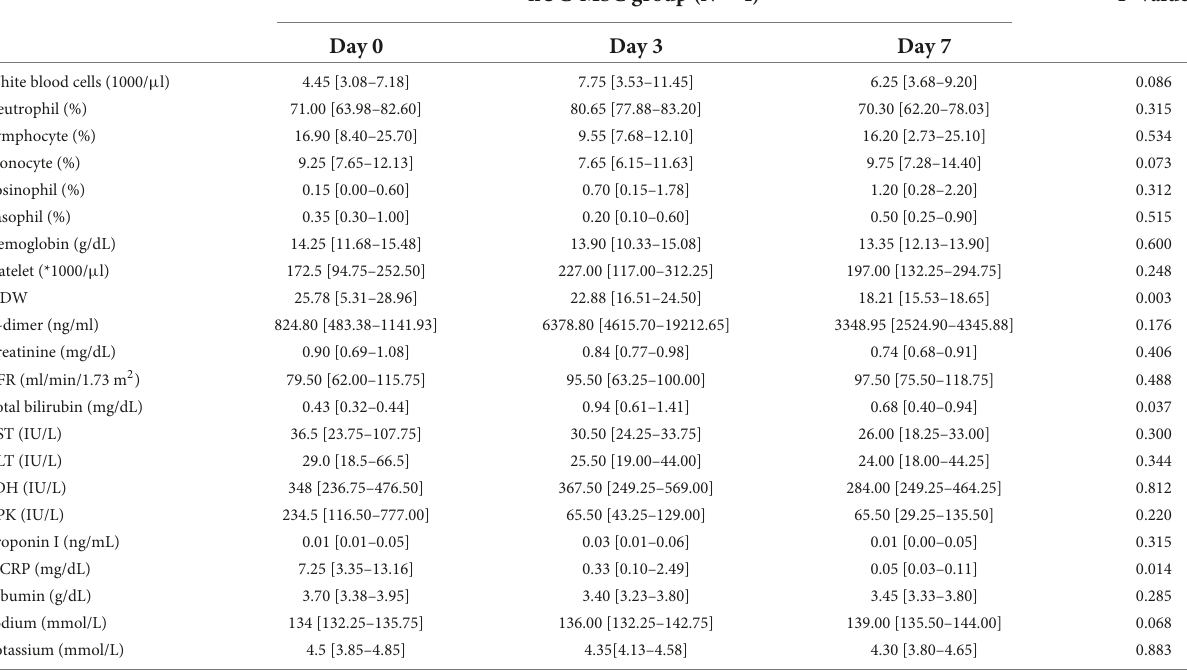
TABLE 2 Serial laboratory data of the human umbilical cord mesenchymal stem cell (hUC-MSC)